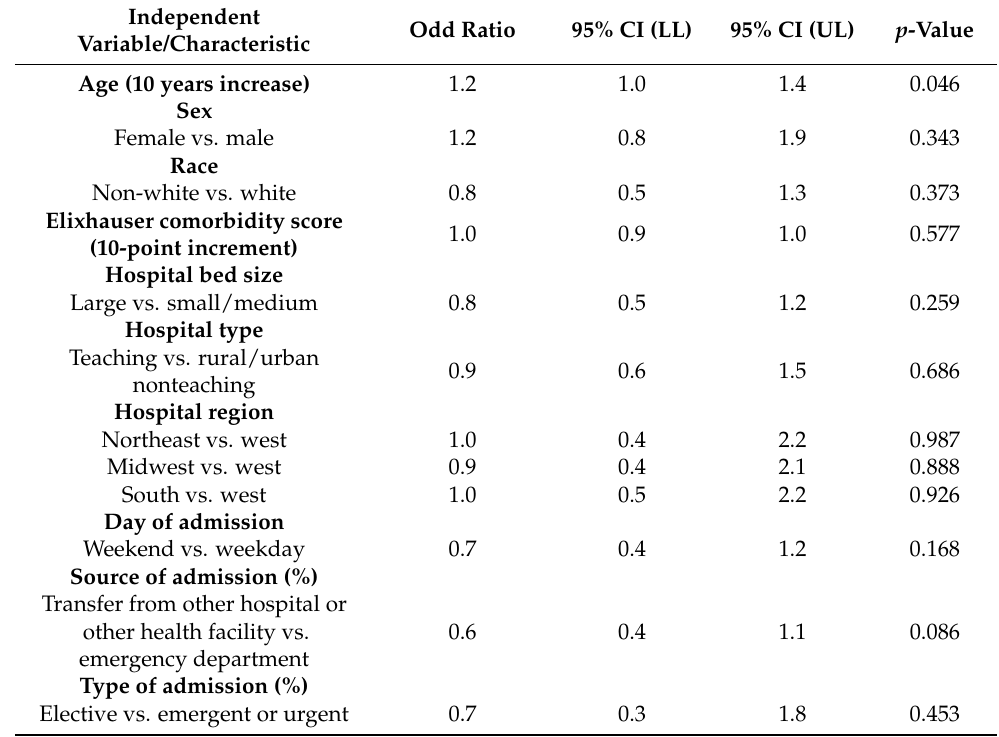
Table 4. Predictors of mortality in surgical